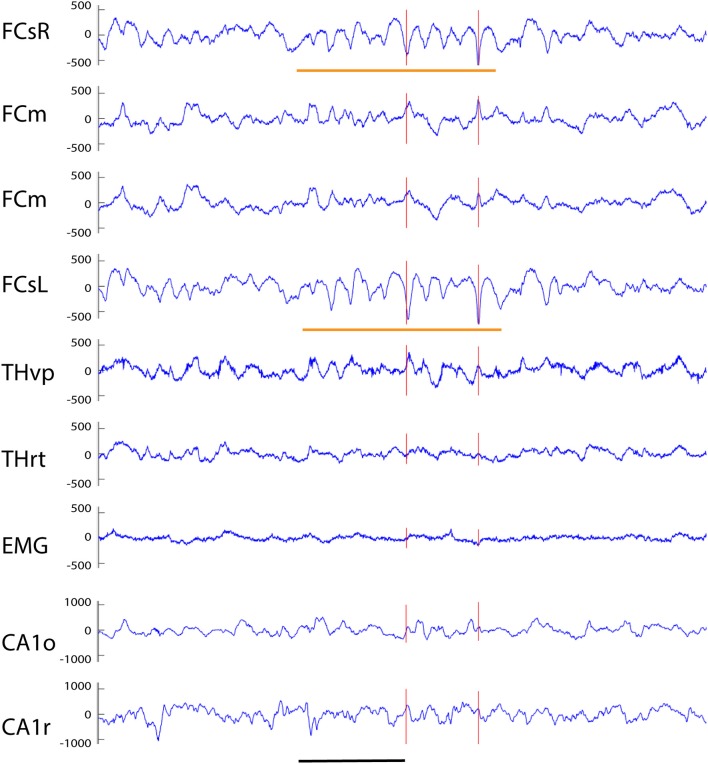
Example of a spindle-associated spikes recorded from a wild-type mouse. A clear sinusoidal spindle oscillation, in this case 11 Hz, can been seen on both frontal screw channels with a 10–15 ms offset (orange horizontal lines). The red vertical lines indicates those spikes on the FCsR reference channel that exceeded the 6 SD threshold. While the subcortical channels do not reflect the oscillation itself the prominent spikes can be seen in reverse polarity on both medial frontal and thalamic THvp channels. Channel abbreviations as in Figure 2. Scale bar, 500 ms.